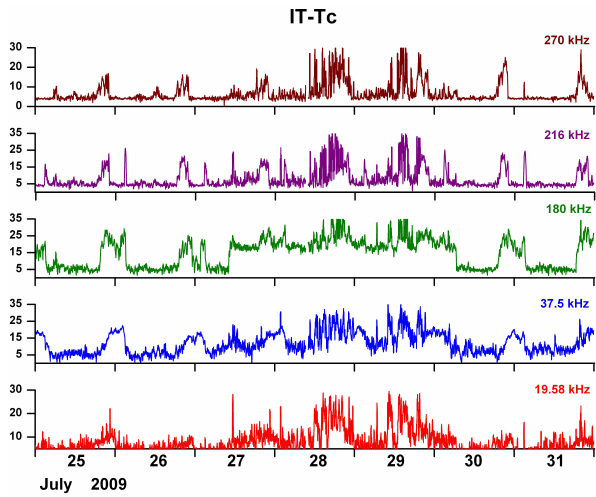
Fig. 9. Trends of the intensity of the CZE (270kHz), MCO (216kHz), TRT (180kHz), NRK (37.5kHz) and GBZ (19.58kHz) radio signals collected by IT-Tc receiver during 25–31 July, 2009. From 27 to 30 July, an increase/disturbance happens on all the trends.